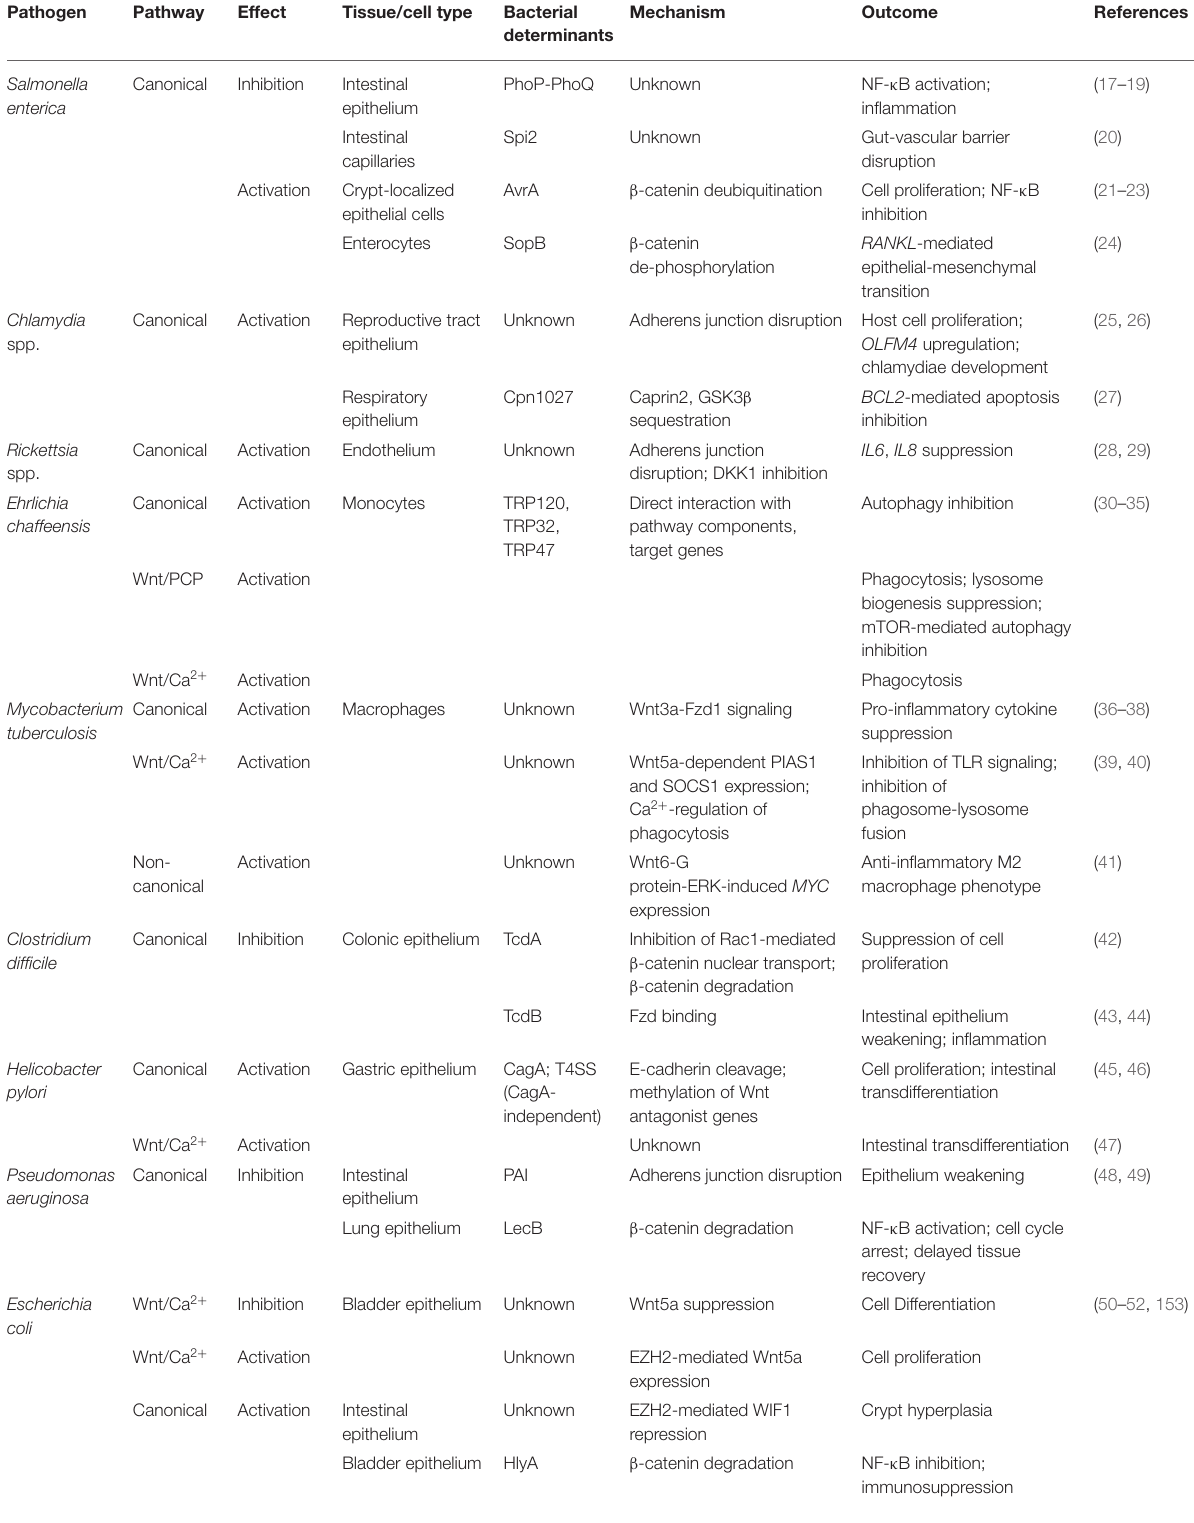
TABLE 1 | Summary of the role of Wnt signaling pathways and respective bacterial factors involved in the pathogenesis of representative bacteria.